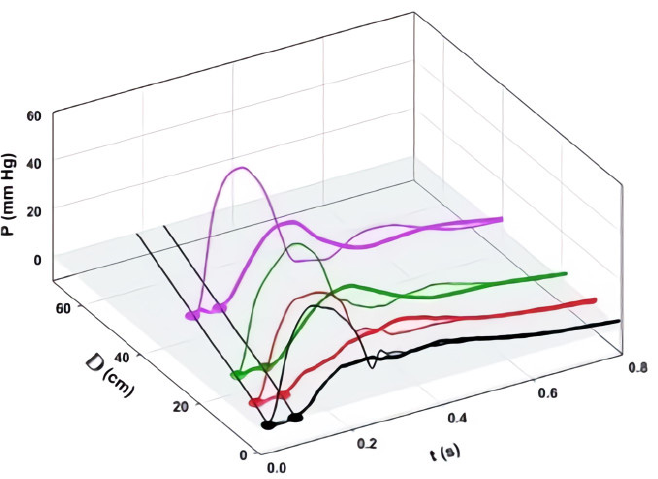
, thin lines) and “backward-going” ( P , thick lines) pressure waves based on measured Figure 9. Separation of forward- ( P f b pressures and flows, according to the classical method [10]. At every location, note that P follows P by approximately the same b f interval [8] Note. Reprinted with permission from “Wave propagation and reflection in the canine aorta: analysis using a reservoir-wave approach” by Wang JJ, Shrive NG, Parker KH, Hughes AD, Tyberg JV. Can J Cardiol. 2011; 27:389. (https://doi.org/10.1016/j. cjca.2010.12.072). © Elsevier.